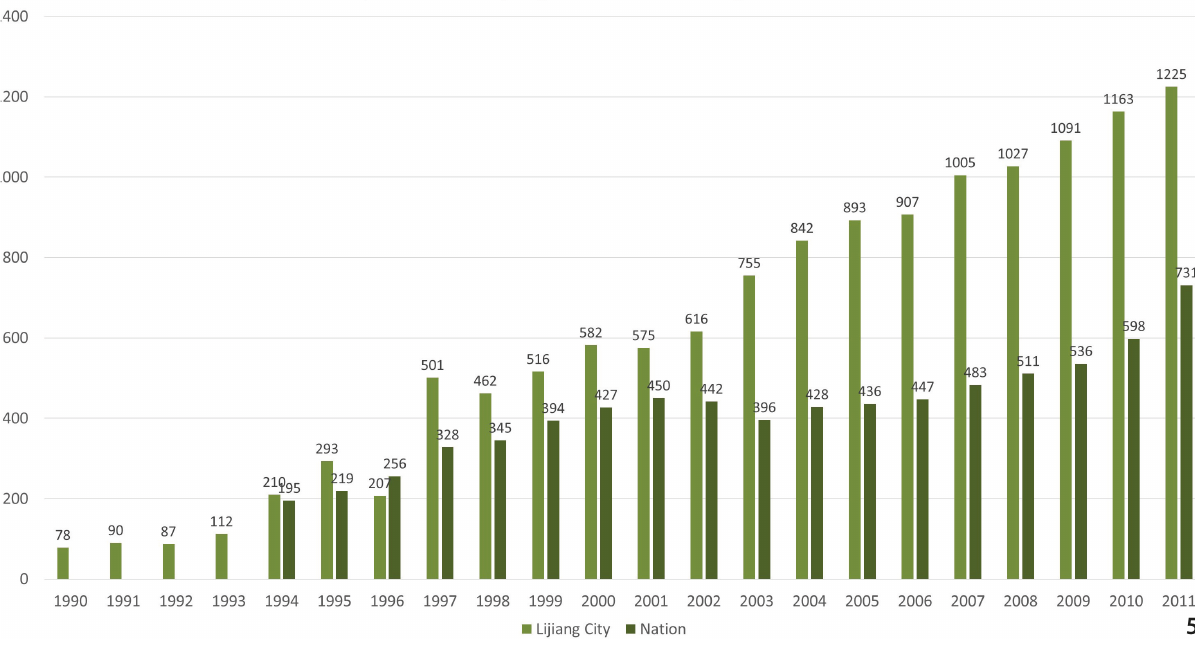
Figure 5 Comparative evolution of expenditure by tourists in Lijiang and in China, between 1990–2011 (Units: CNY per person per visit) 2 (Source: Drawn by the author according to the Statistical Yearbooks and Statistical Bulletins of whole China, Lijiang Municipality and Gucheng